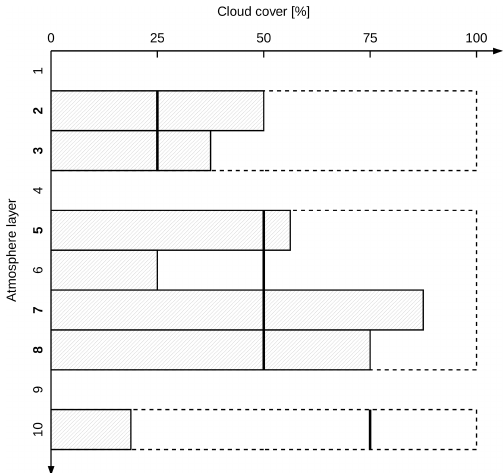
Figure A1. Scheme illustrating determination of cloud layers. Shaded boxes with solid borders show cloud layers with cloud cover percentages given by their horizontal extent. Adjacent cloud layers are combined to groups outlined by broken borders. For each group a bold vertical line marks the intersection position used for layer de- termination. Atmosphere layer numbers in bold indicate intersected cloud layers, which generate a cloudy layer during the set-up.